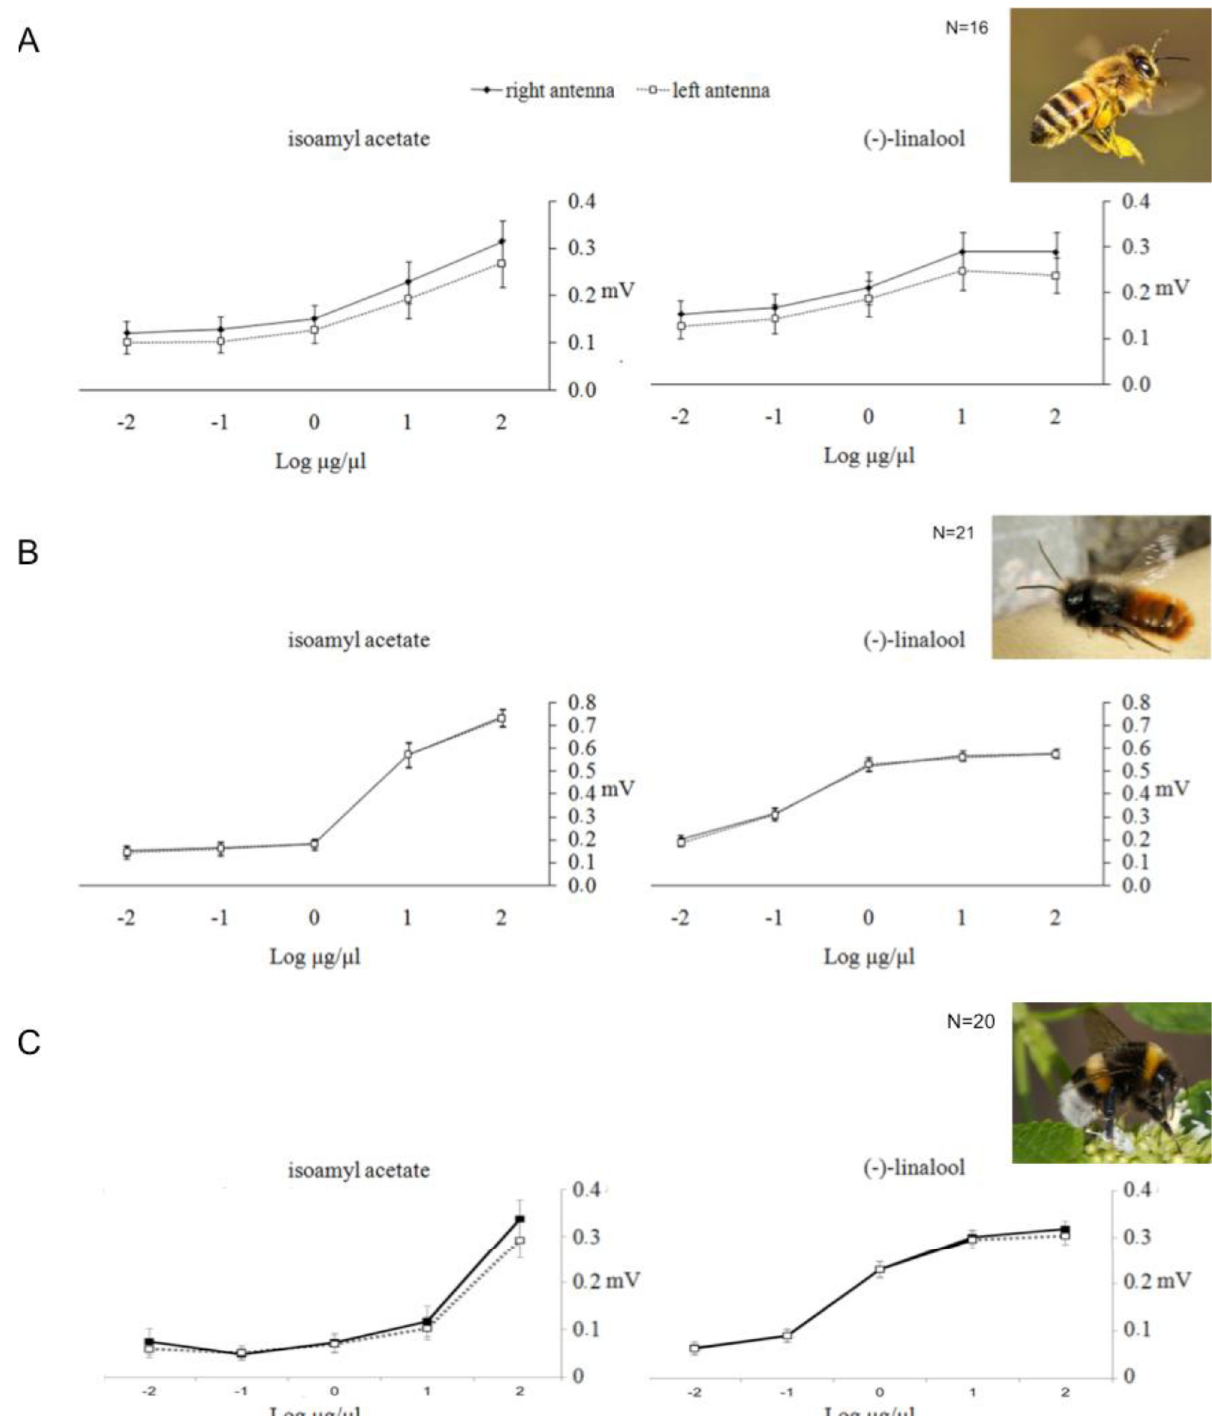
Figure 3. Electroantennographic (EAG) responses. Mean EAG ± SEM absolute responses (mV) of right (unbroken lines with black squares) and left (dotted lines with empty squares) antenna of ( A ) A. mellifera (N = 16), ( B ) O. cornuta (N = 21) and ( C ) B. terrestris foragers (N = 20) to isoamyl acetate (left) and ( (cid:237) )-linalool (right) at five different doses µg/µL). (From (Log 10